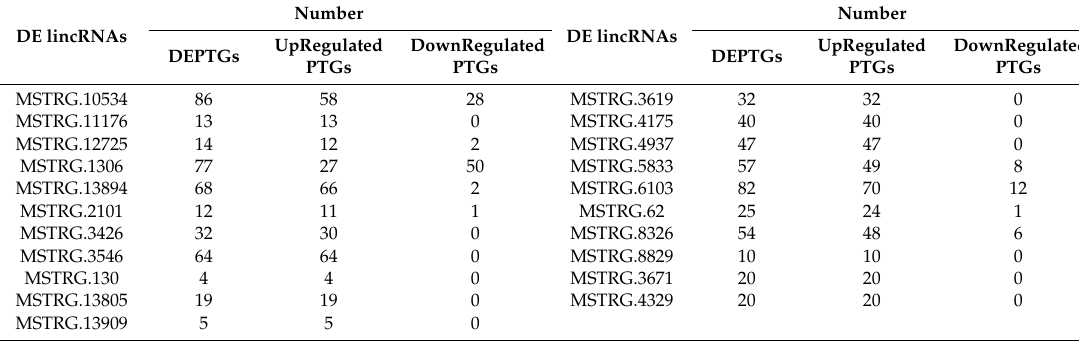
Table 3. Summary of di ff erentially expressed lincRNAs (DE lincRNAs) and their di ff erentially expressed potential target genes